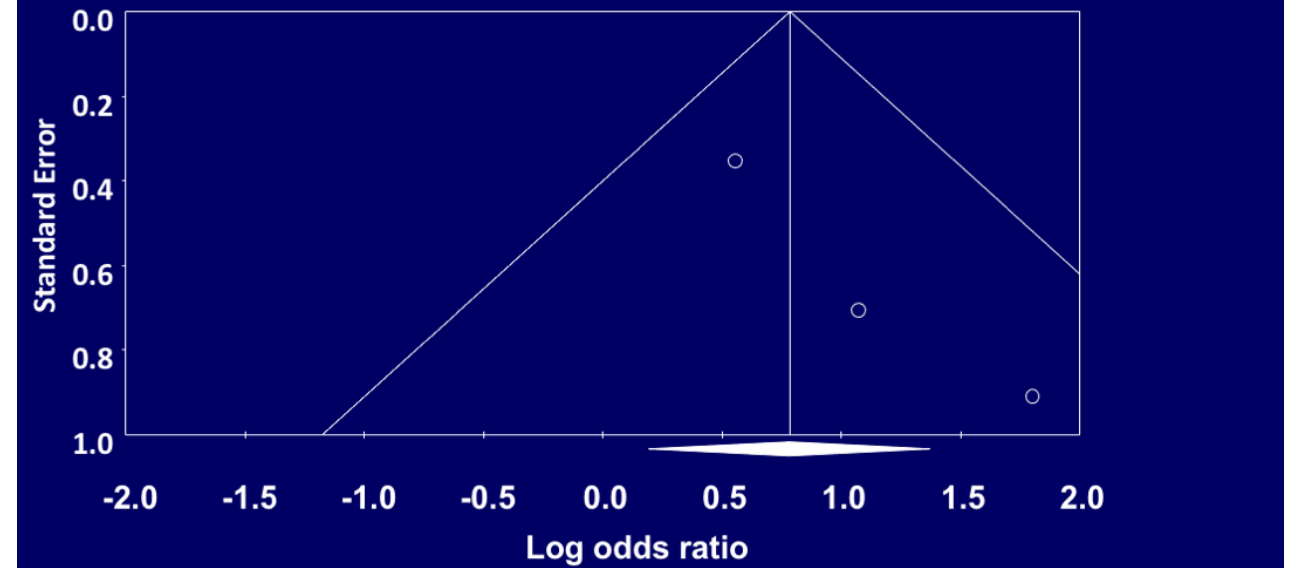
Figure 5. Funnel Plot of Standard Error by Logs Ratio for Delayed Union.